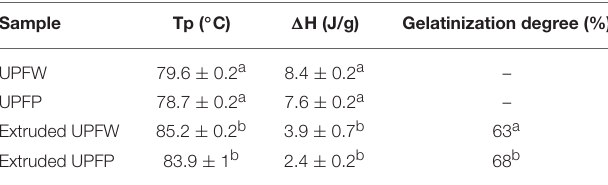
TABLE 1 | Temperature (Tp) and enthalpy of gelatinization ( 1 H), and gelatinization degree determined by differential scanning calorimetry of native and extruded flours of unripe plantain pulp (UPFP) and whole fruit